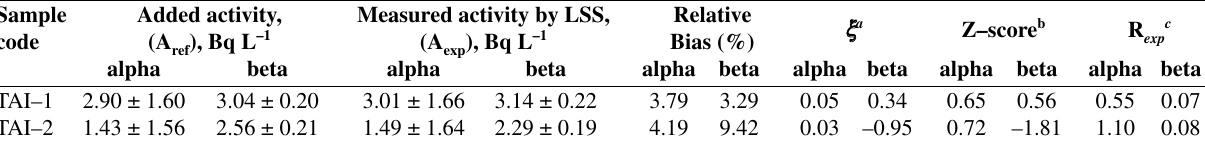
Table 3. The experimental results for gross alpha/beta compared to reference values of activity concentration in added spike solution Sample Added activity, Measured activity by LSS,